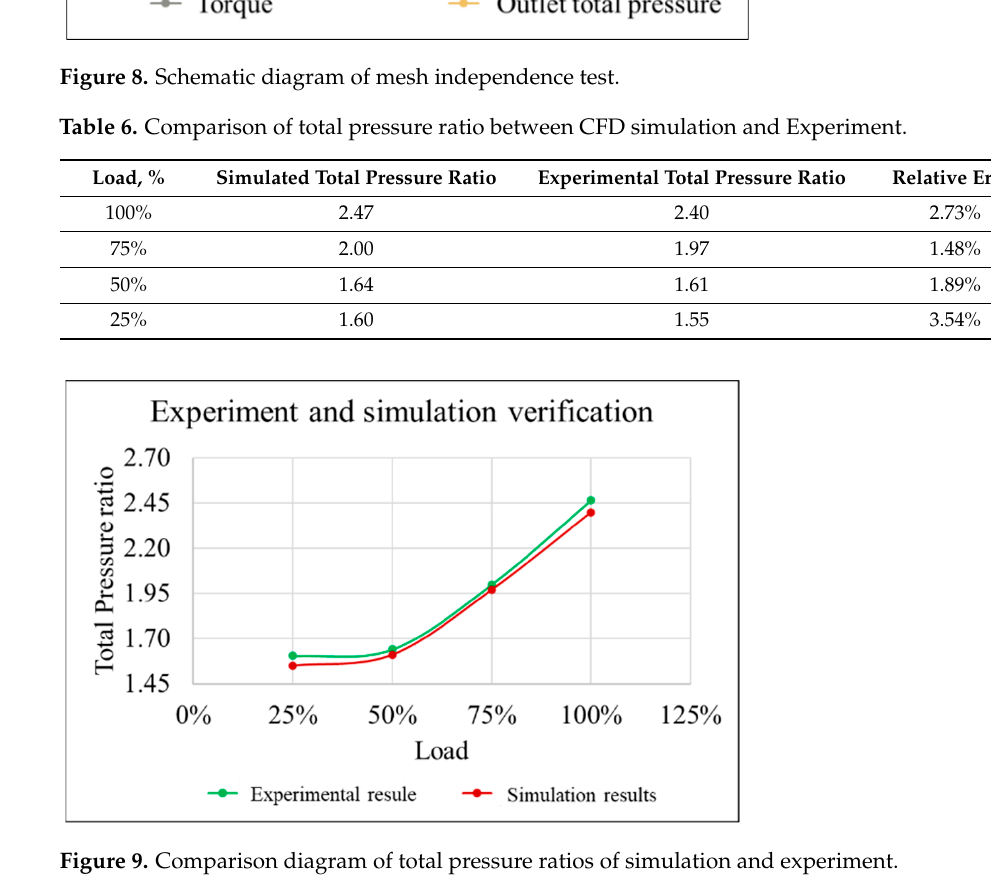
Figure 8. Schematic diagram of mesh independence test .